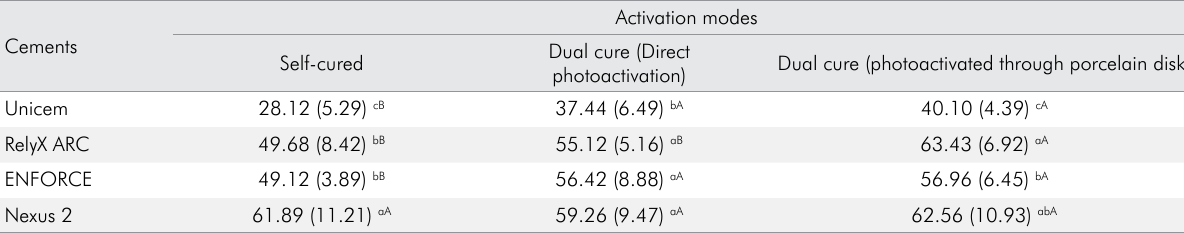
Table 3. Means of Diametral Tensile Strength (MPa) with standard deviations shown in parentheses.